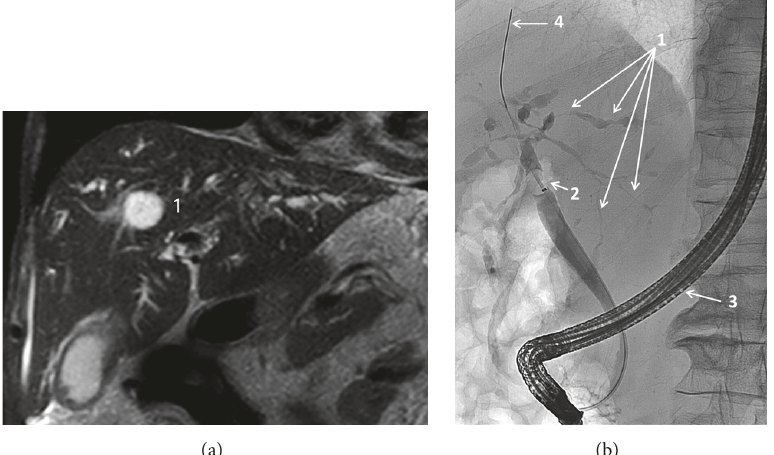
Figure 1: Imaging findings in a patient with IgG4-related sclerosingcholangitis (IgG4-SC). (a)At magneticresonanceimaging, no tumor-like lesions are seen. A benign hepatic cyst is indicated (1). (b) Diffuse and multiple intrahepatic biliary stenoses and dilatations at endoscopic retrograde cholangiography (1). The stenoses are relatively long. In classical primary sclerosing cholangitis (PSC), the stenoses would have been shorter, giving the cholangiogram a more beaded appearance. No complete obstruction of a bile duct is seen, a finding that would have been more characteristic of bile duct carcinoma. 2: occlusive balloon, 3: endoscope, 4: guide